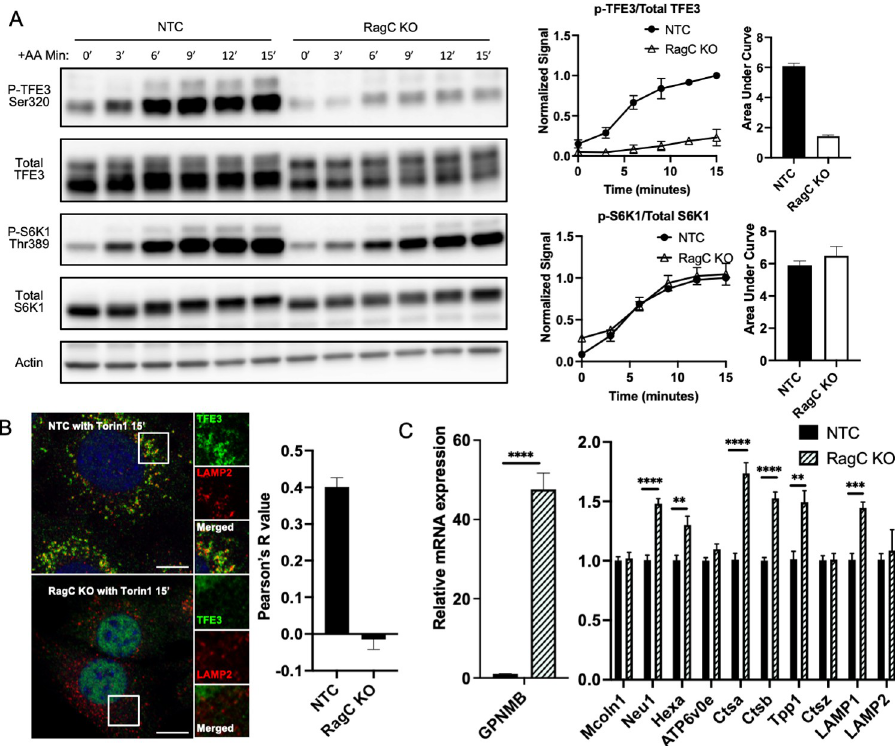
Fig 5. RagC is necessary for AA-stimulated TFE3 phosphorylation and localization to lysosome. (A) Control C2C12 cells and cells lacking RagC were maintained for 60 minutes in medium lacking AAs and then returned to complete media for the indicated times, followed by immunoblotting as indicated. Phospho-TFE3/totalTFE3 and phospho-S6K/totalS6K were quantified and normalized to the 15-minute time point of NTC (control). (B) Control C2C12 cells and cells lacking RagC were cultured with 250 nM Torin1 for 15 minutes, followed by immunohistochemistry for subcellular localization of TFE3 and LAMP2, a marker of the lysosome. (Scale bar: 10 μ m). On the right: correlation by Pearson’s R of LAMP2 and TFE3 staining. (C) Quantitative PCR evaluation of expression of the indicated genes (normalized to the average expression of HPRT, TBP, and 36B4 as controls). �� p < 0.01, ��� p < 0.001, ���� p < 0.0001 by Student t test. The data underlying all the graphs shown in the figure is included in S1 Data. AA, amino acid; KO,